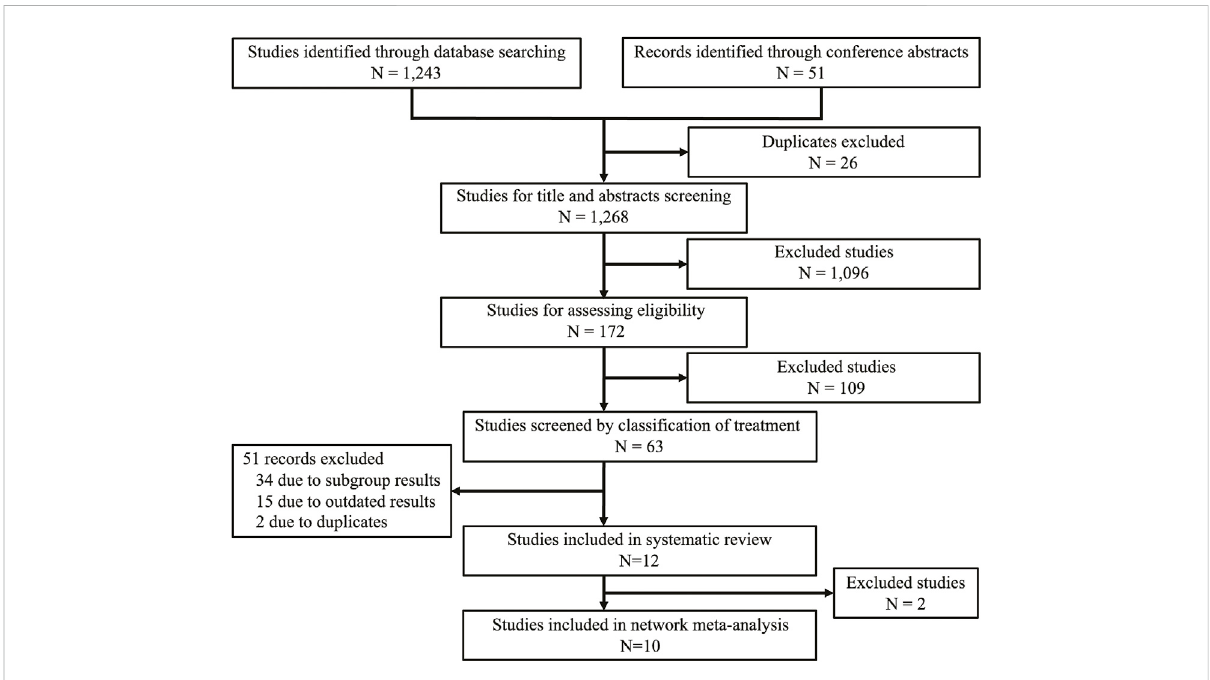
FIGURE 1 Study selection fl